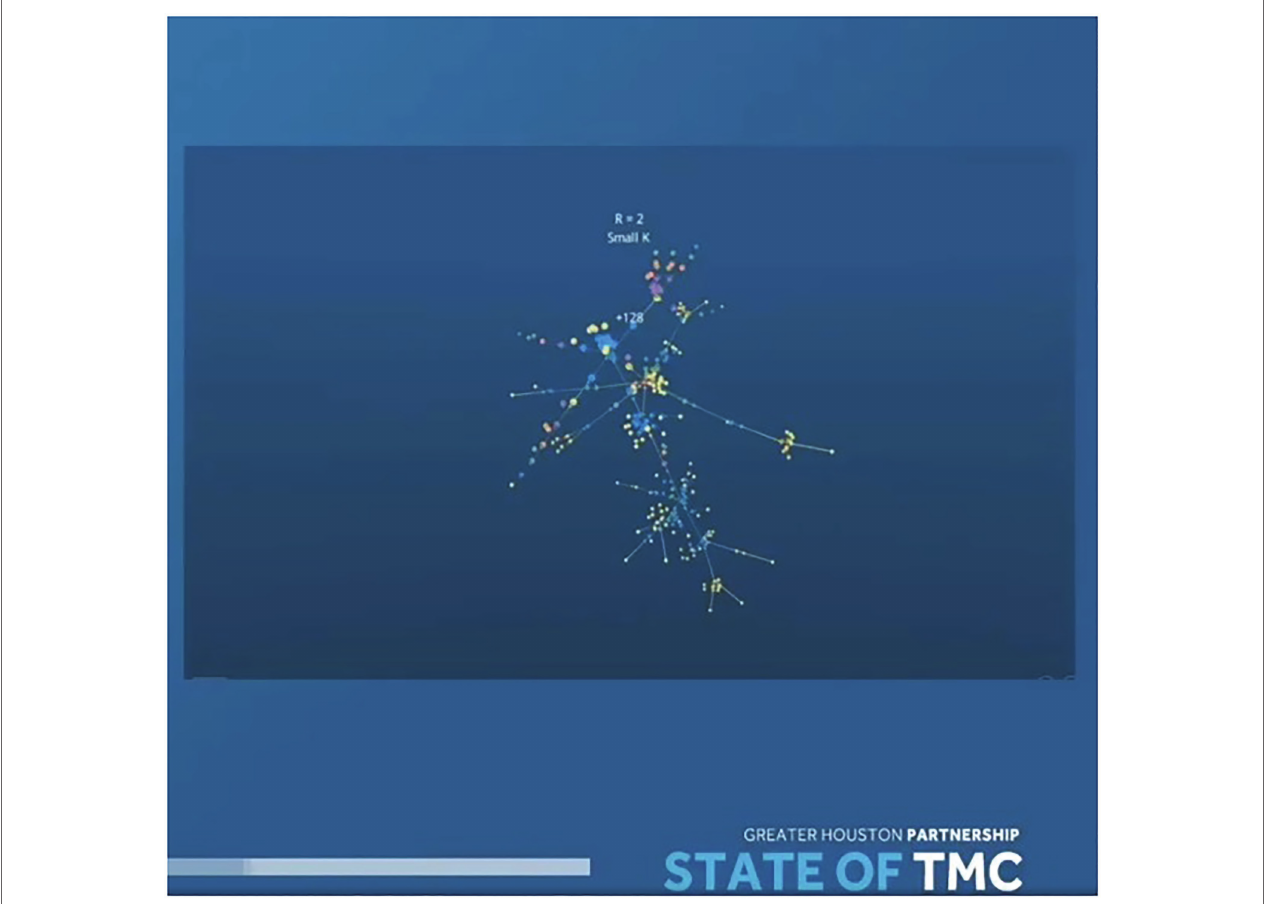
FIGURE 6 | A YouTube Snapshot from the Texas Medical Center’s “State of the TMC”